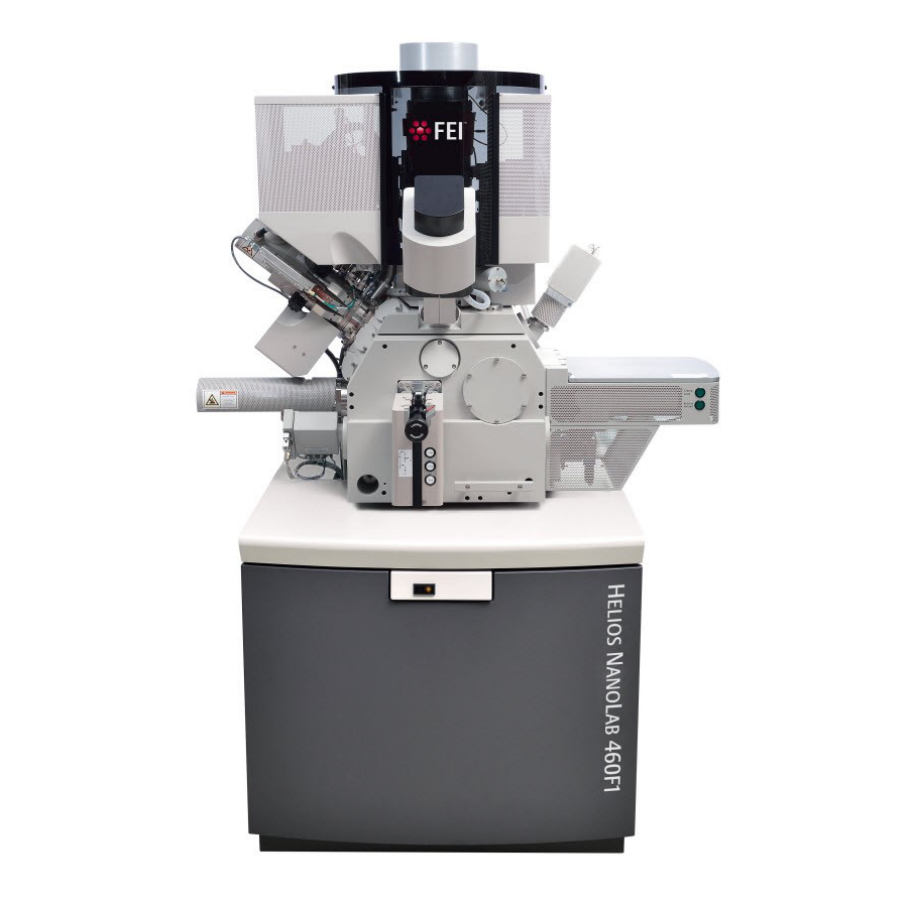
Figure 1: FEI Helios NanoLab 460F1 DualBeam (photograph by courtesy of FEI